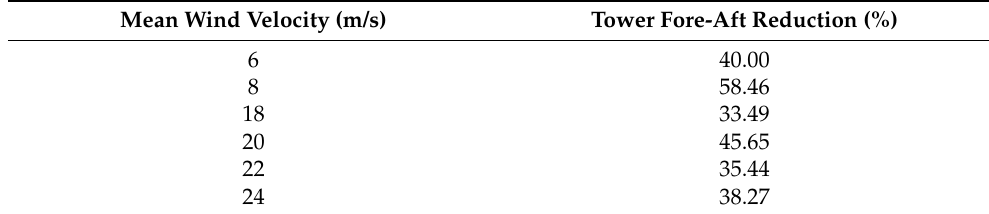
Table 6. The reduction of fore-aft vibration in constant turbulence intensity of 10%, and different mean wind speed values.